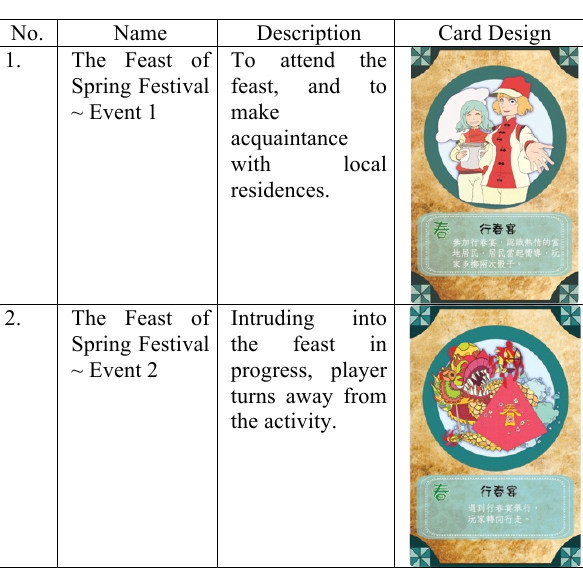
Table 1. Character Card Setting and Design No. Name Description